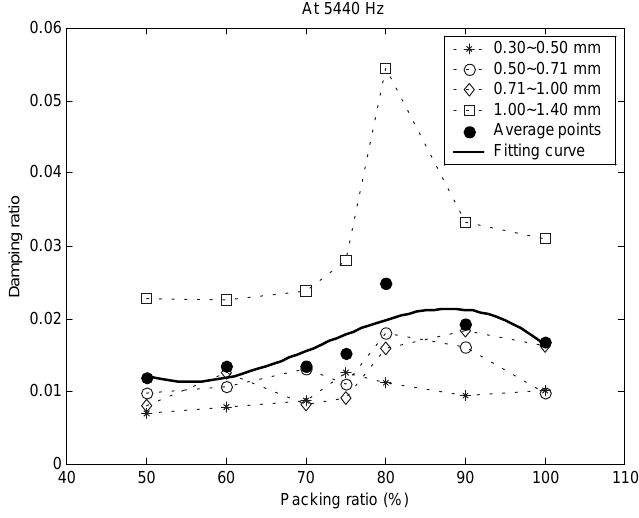
Fig. 8. Damping ratio vs. packing ratio for different particle diameters at 5440